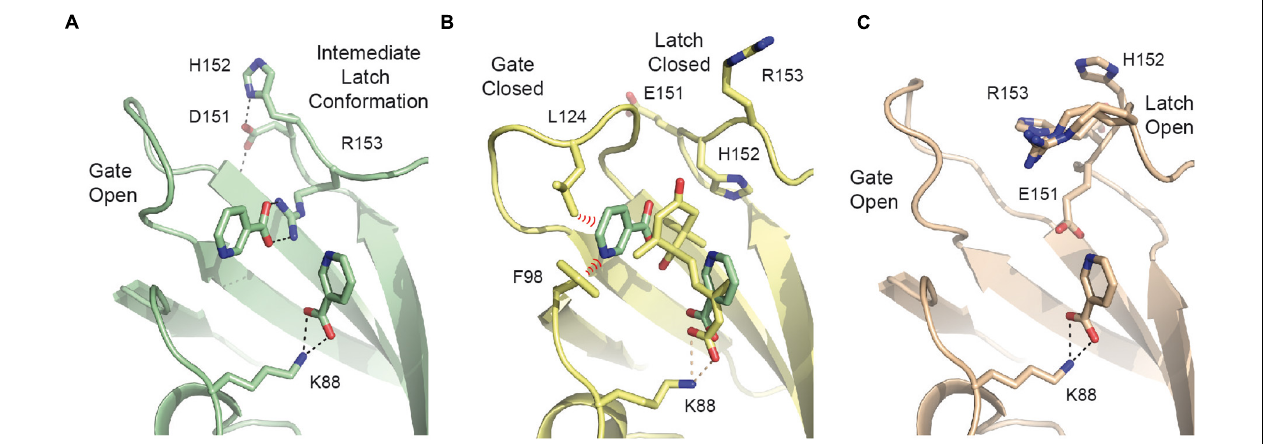
FIGURE 4 | The SlPY1 E151D Niacin complex. (A) The network of hydrogen bond interactions with niacin in the complex with SlPYL1 E151D. (B) The overlay of the niacin molecules from the complex with SlPYL1 E151D onto the CsPYL1-ABA-HAB1 complex, residues are labeled according to SlPYL1 sequence. Red dashed symbols highlight hypothetical short unfavorable clashes between niacin and residues of the gate loop in closed conformation. (C) The network of hydrogen bond interactions with niacin in the complex with